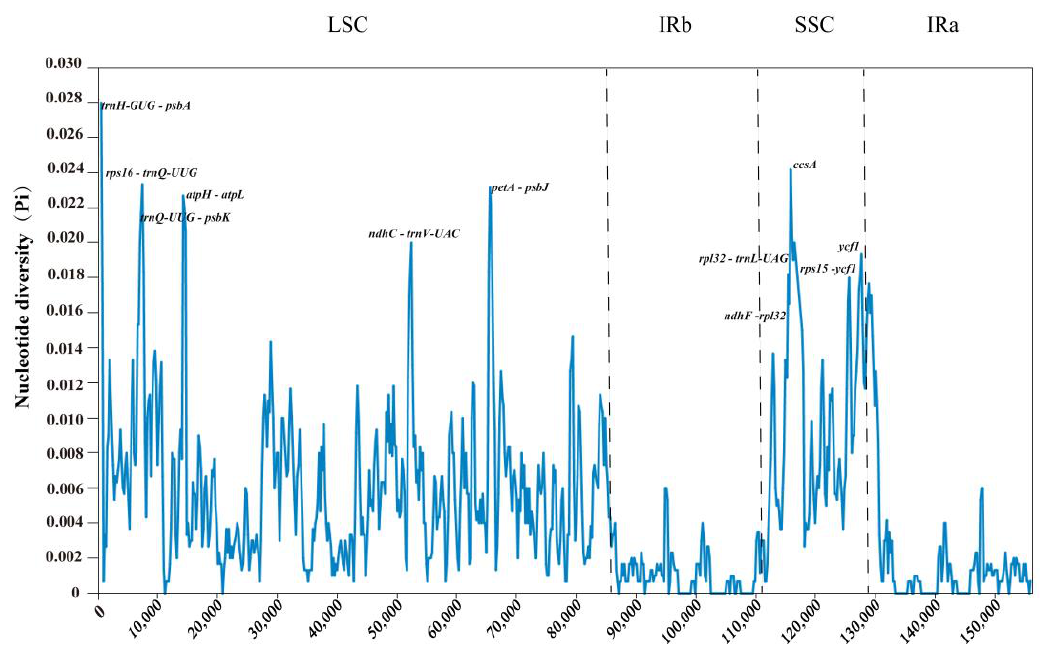
Figure 13. The nucleotide variability (Pi) values were compared among five Uncaria species. Position of the window midpoint on the X-axis and the nucleotide diversity within each window on the Y- (window length: 600 bp, step size: 200 axis (window length: 600 bp, step size: 200 bp).